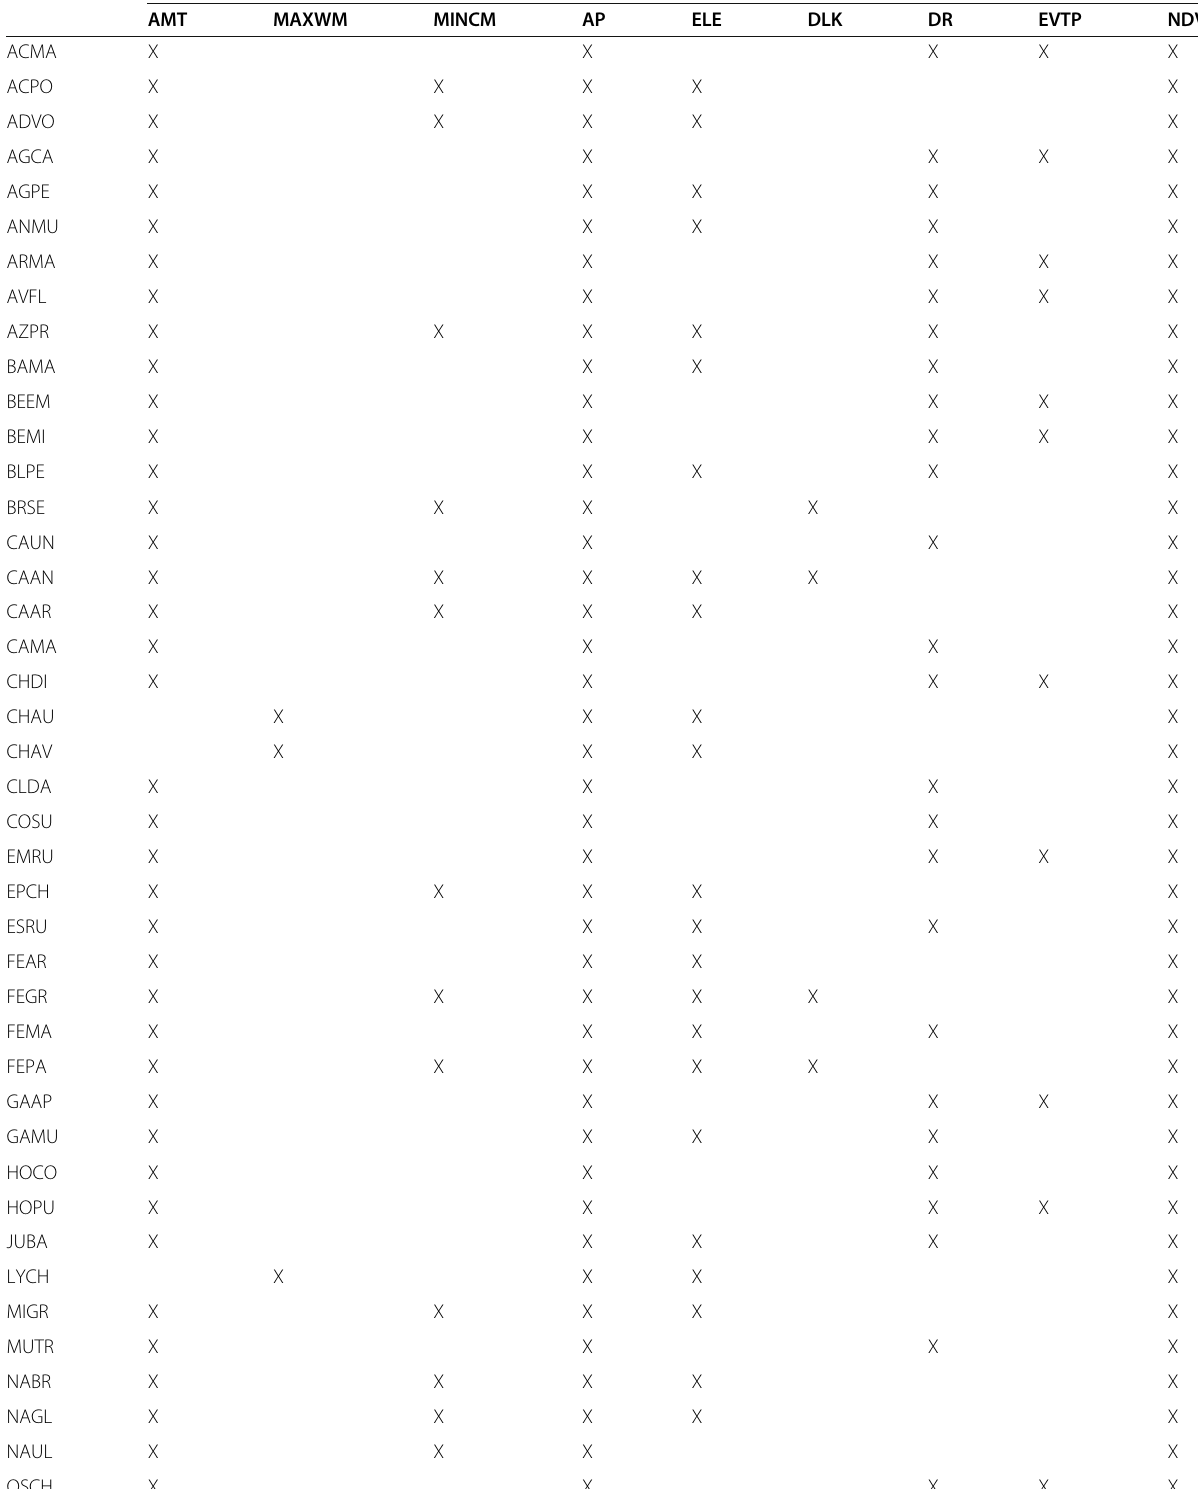
Table 4 Environmental variables used for each plant species modelling of the potential habitat suitability in Santa Cruz